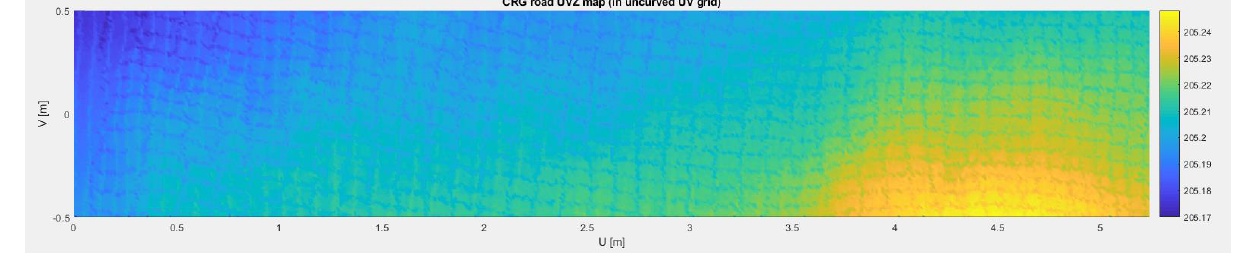
Figure 6. The grid map of the TLS pilot site